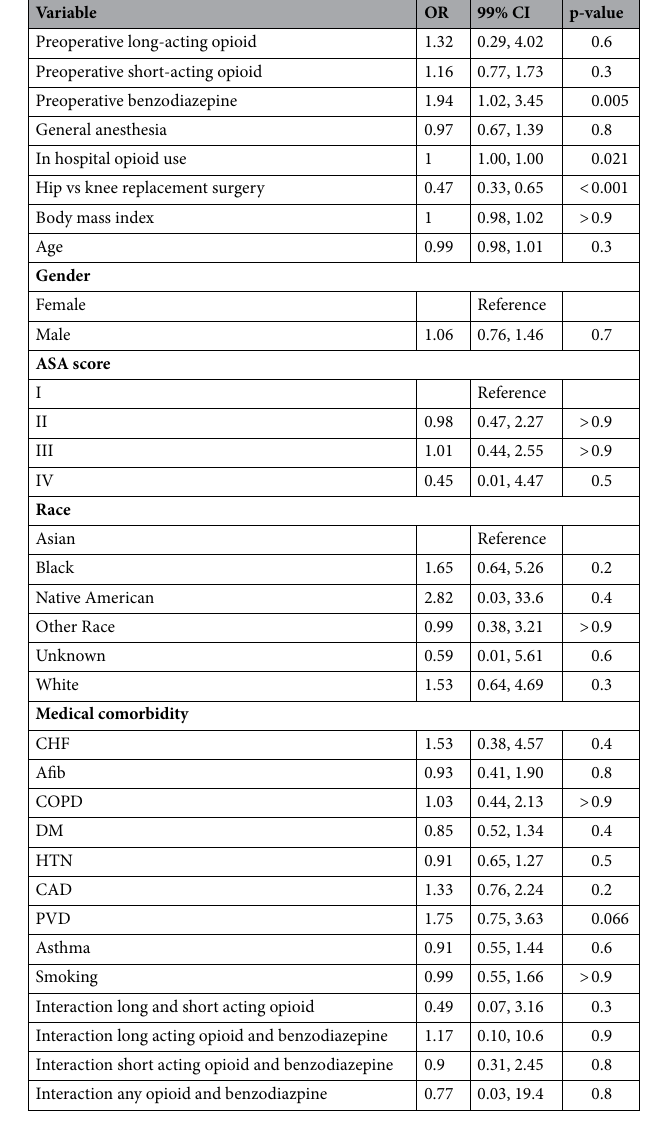
Table 2. Regression results for readmission. Afib atrial fibrillation, ASA American Society of Anesthesiologists, CAD coronary artery disease, CHF congestive heart failure, CI confidence interval,